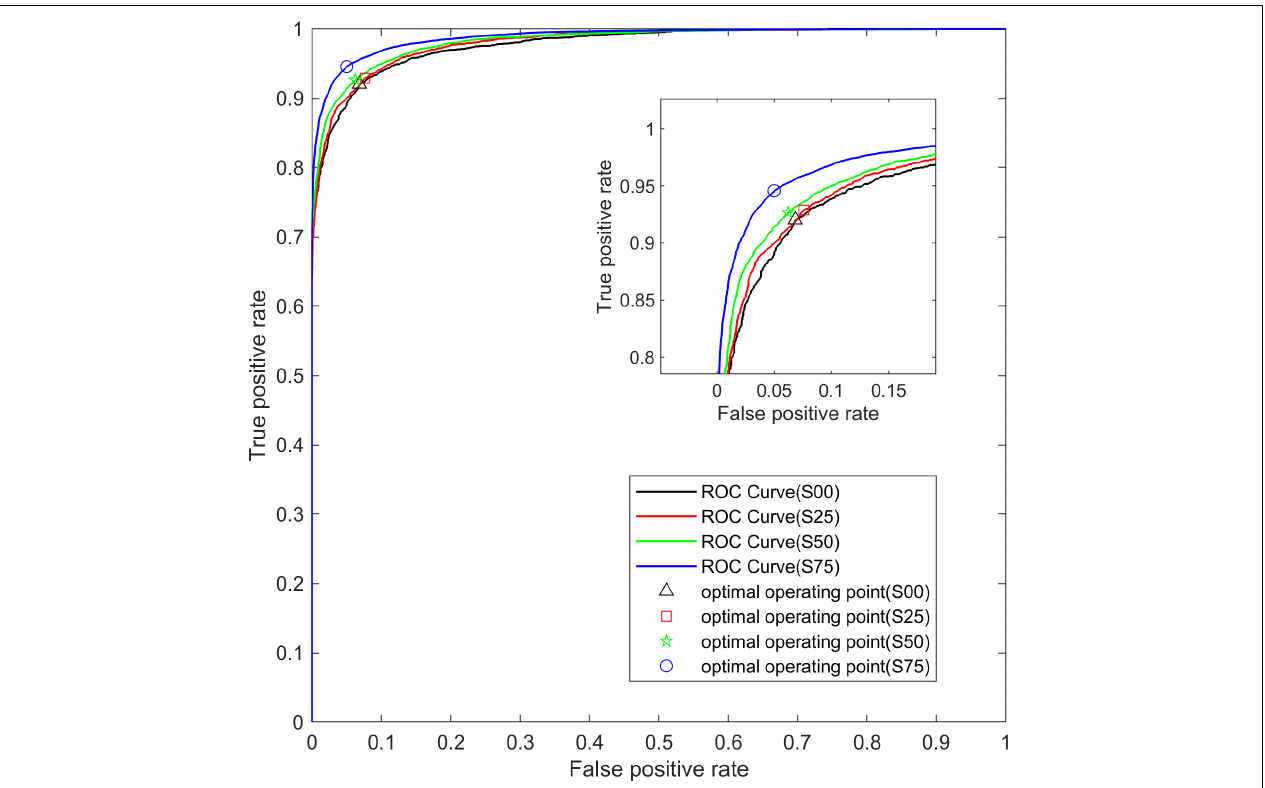
FIGURE 5 | The average ROC curve under different segmentation overlap rates. The abscissa is False Positive Rate (1-Specificity) and the ordinate is True Positive Rate